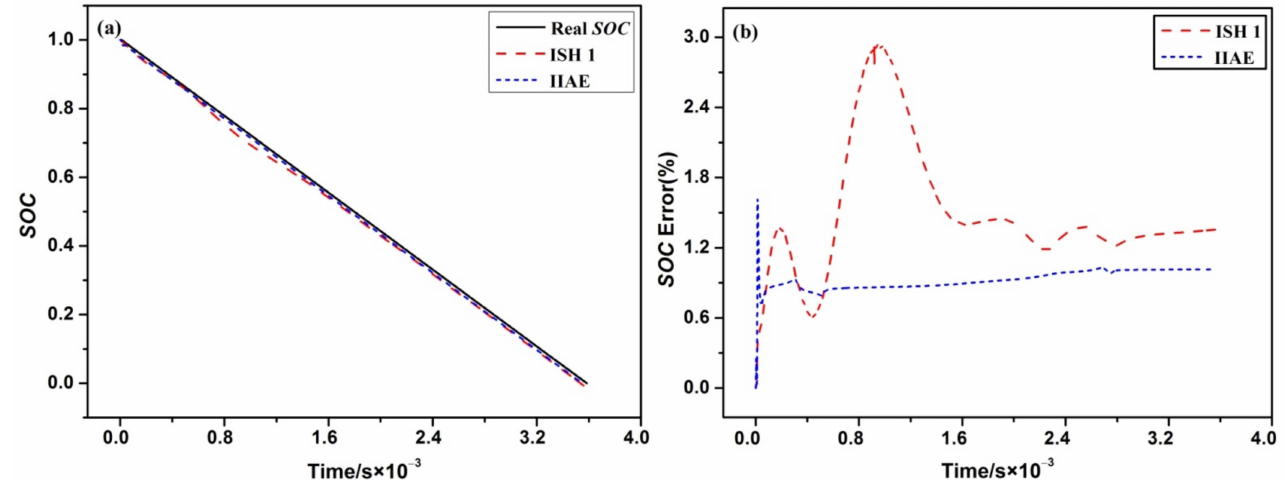
Figure 6. ( a ) The SOC estimation results of the improved algorithm under the CCD condition. ( b ) The SOC estimation error result of the improved algorithm under the CCD condition.